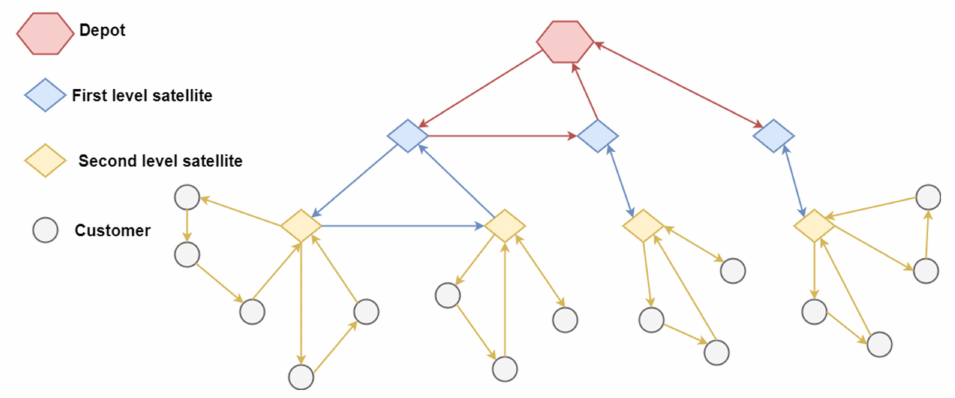
Figure 1. Multi-Echelon Vehicle Routing Problem